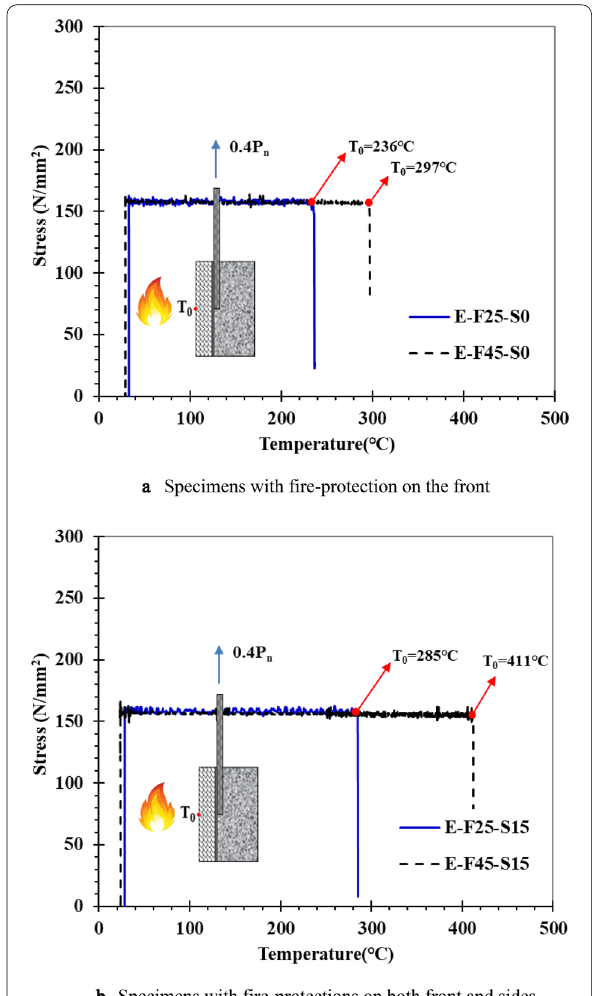
Fig. 12 Temperature–stress curve of NSM specimens with